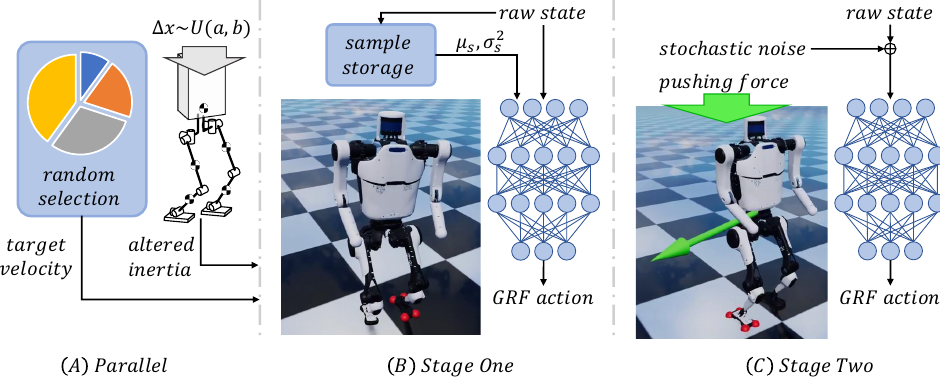
Figure 3. Curriculum schema. Section ( A ) shows parallel randomization curriculum including mass, inertia and task goal randomization. ( B ) shows first curriculum stage with ideal training environment. ( C ) describes second curriculum stage with sensor noise and random force perturbations. Check Section 3.2 for more